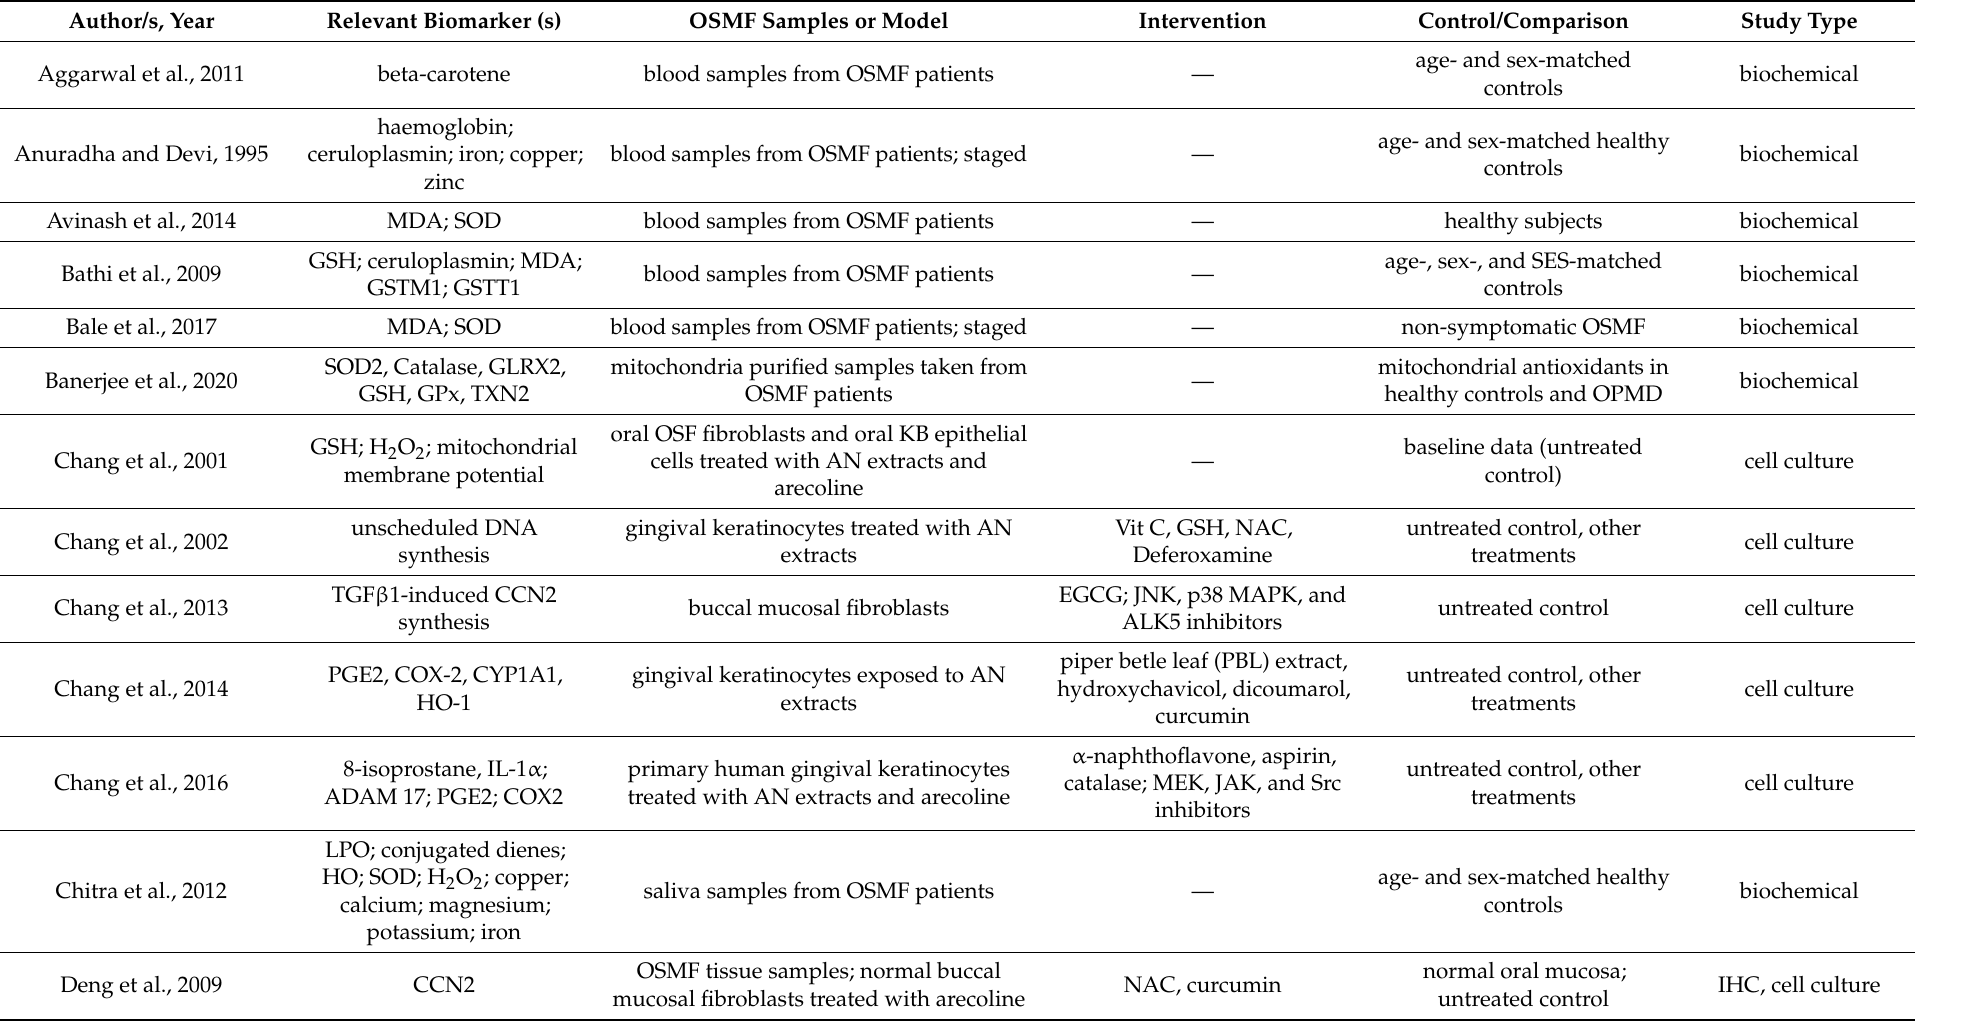
Table 1. Overview of laboratory-based studies that were eligible for